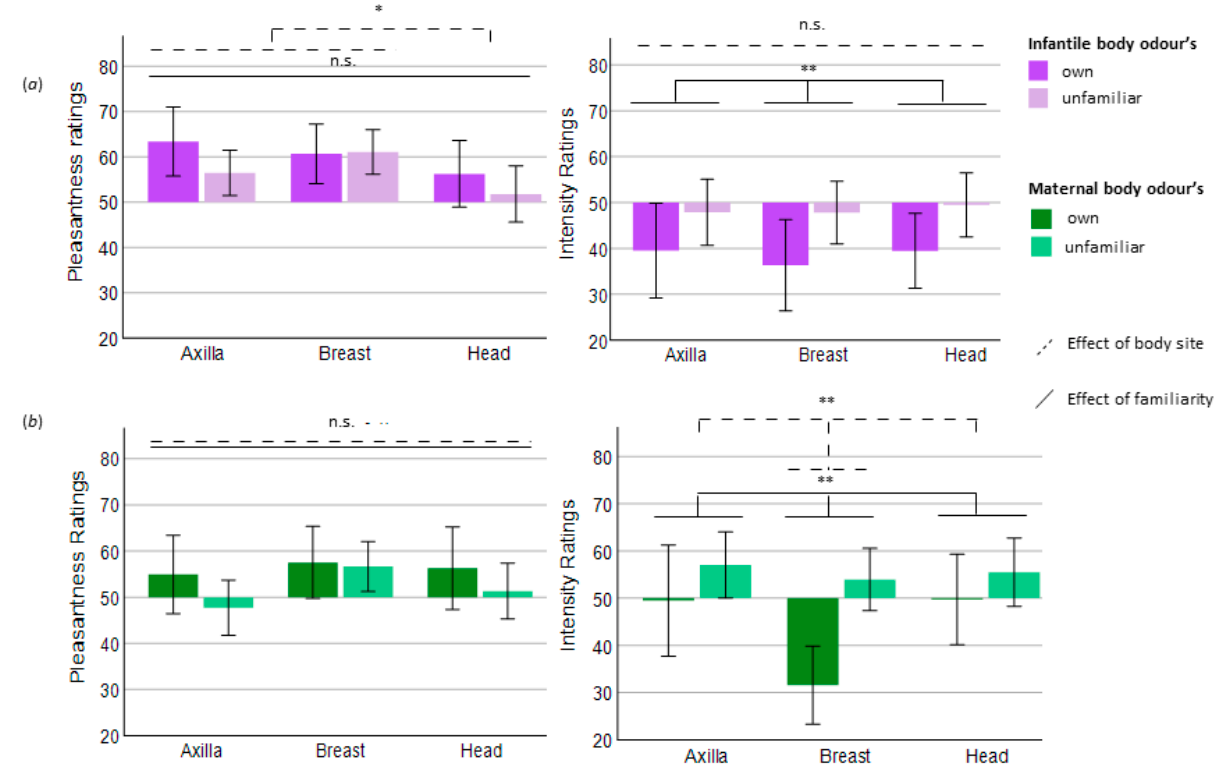
Figure 2. Perceived quality of the BO samples. ( a ) Infantile body odours. ( b ) Maternal body odours. * p < 0.05; ** p < 0.01; n.s. = not significant ( p > 0.05). Pleasantness and intensity were measured with a visual analogue scale, ranging from 0 (“not pleasant”/“not intense”) to 100 (“very pleasant”/“very intense”). A rating of 50 therefore means a neutral evaluation of the odour, which is why this serves as the origin of the bars. Error bars: +/ − 2 standard deviations.